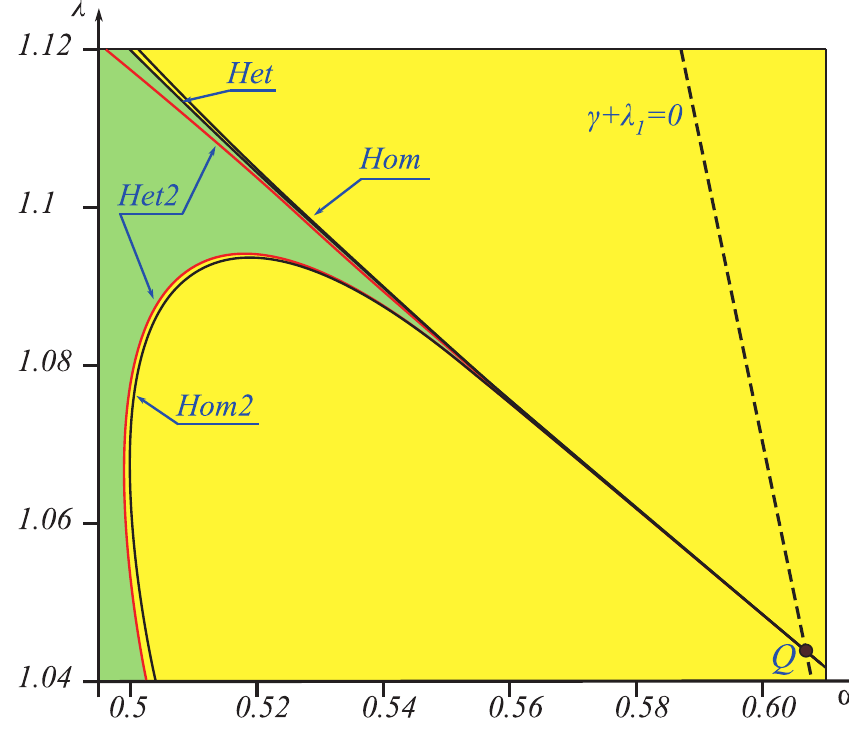
Fig. 2 Bifurcation diagram for the Shimizu-Morioka system near the point Q ( α = 0 . 608 , λ = 1 . 044 ) which corresponds to the homoclinic figure-8 bifurcation to a saddle with zero saddle value. (The green region corresponds to parameter values where the Lorenz attractor